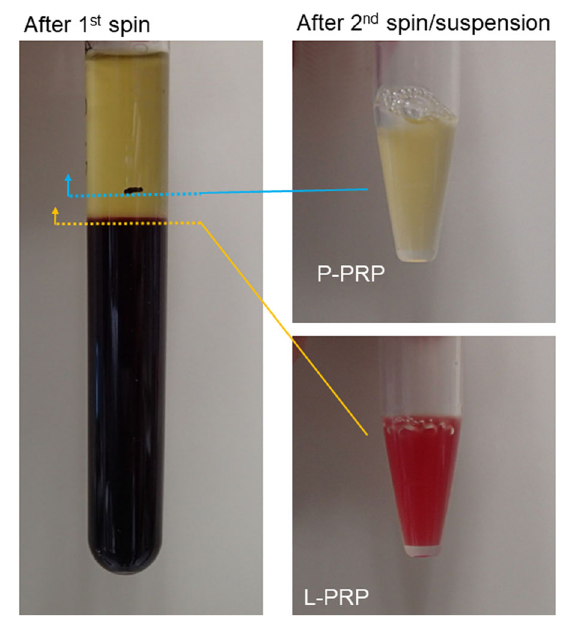
Fig. 2 The appearance of blood sampled after gravity fractionation and the resulting P-PRP and L-PRP. In the first low-speed spin, samples were centrifuged for 10 min at 533× g . For P-PRP preparation, the upper plasma fraction, which was 2 mm beyond the interface between plasma and RBC fractions, was transferred into sample tubes for the second high-speed spin (2656× g , 5 min). In contrast, for L-PRP preparation, the upper plasma fraction including the buffy coat and the surface of the RBC fraction was used for the second spin. The supernatant (PPP) was excluded by 50 – 70%, and platelets were resuspended in the remaining PPP fraction